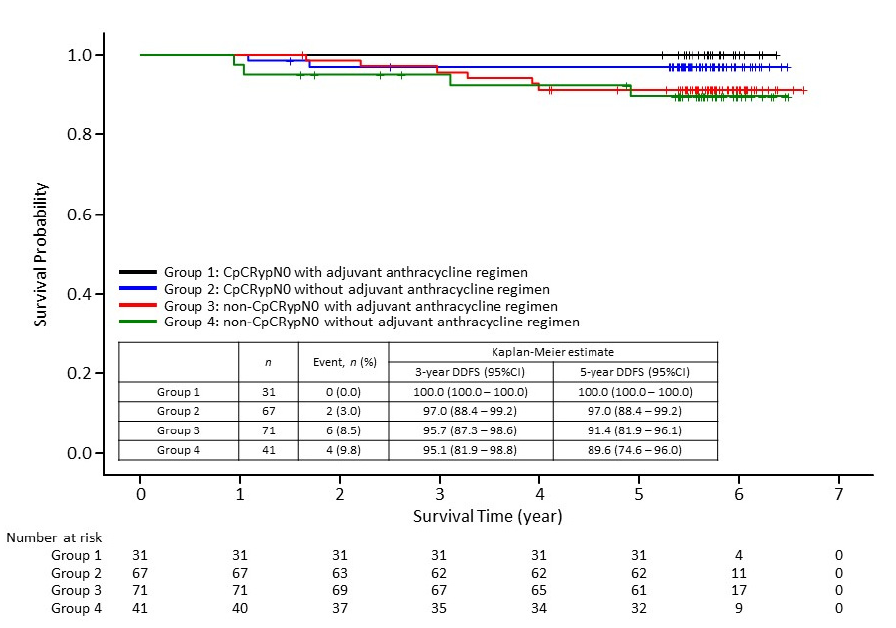
Figure 4. Kaplan–Meier curves of distant disease-free survival (DDFS) stratified by response to neoadjuvant treatment (with or without CpCRypN0) and with or without use of adjuvant anthracycline in all patients ( n = 210). CI, confidence interval; CpCRypN0, comprehensive pathological complete response with a pathologically negative axilla.